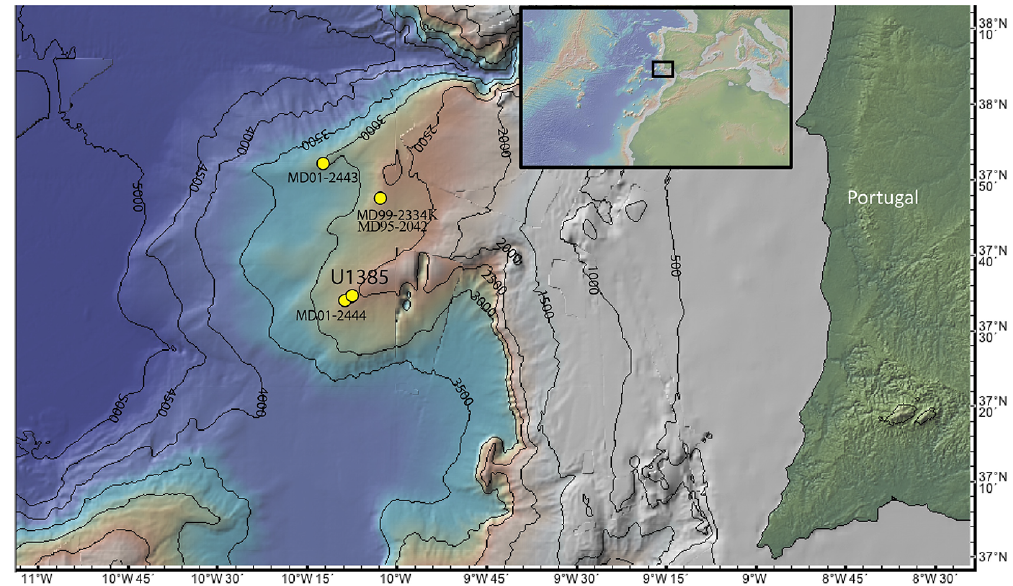
Figure 1. Location of IODP Site U1385 and selected piston (MD95-2042, MD01-2444, MD01-2443) and kasten (MD99-2334K) cores on the Promonotório dos Principes de Avis along the continental slope of the southwestern Iberian margin. The map was made with GeoMapApp (https://www.geomapapp.org/, last access: 15 July 2022) using bathymetry of Zitellini et al.